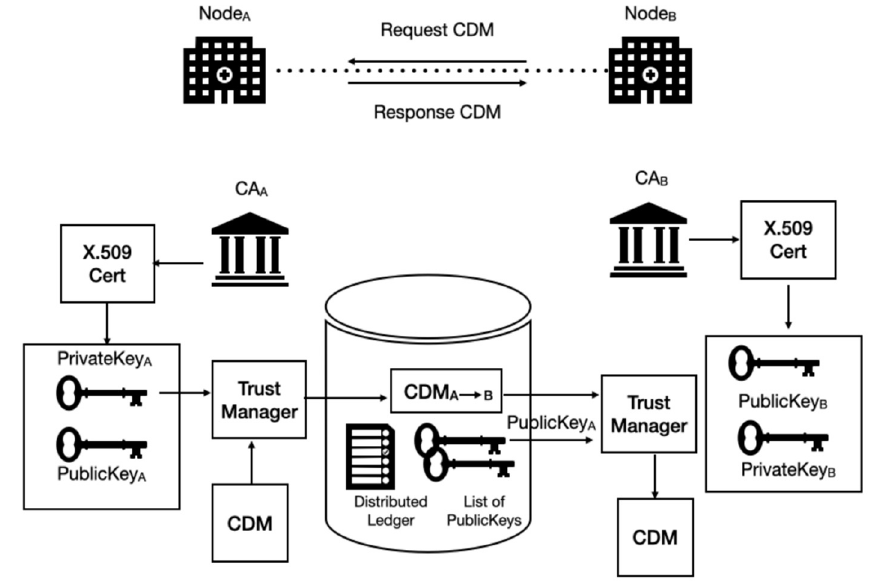
Figure 2. Concept of the Secure-Cloud Common Data Model (SC-CDM) for building CDM A → B .